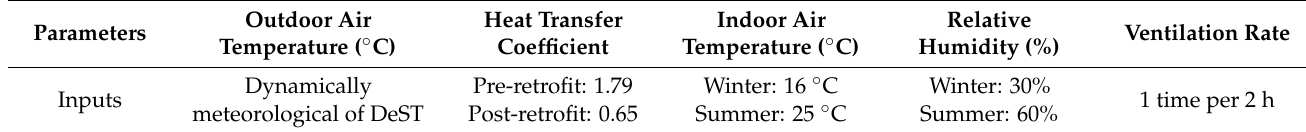
Table A2. Parameter setting of room thermal